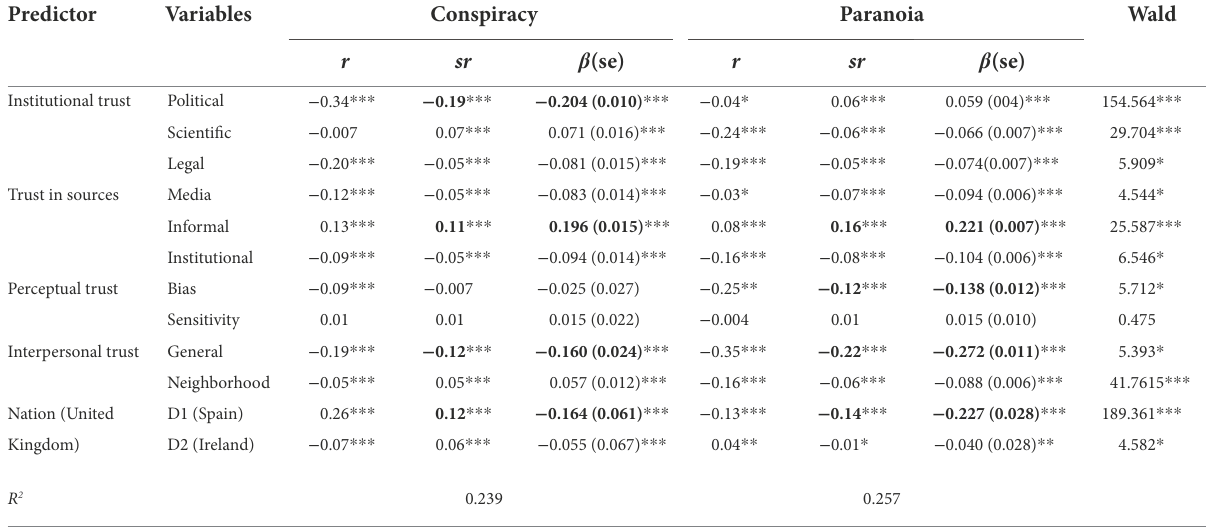
TABLE 4 Bivariate correlations, semi-partial correlations, standardised regression coefficients and Wald tests of equality of constraints from multivariate regression model predicting paranoia and conspiracy beliefs for whole sample controlling for nation.